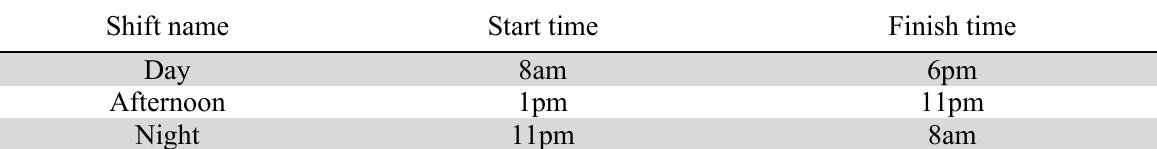
The start and finish time of each shift for ED doctor Shift name